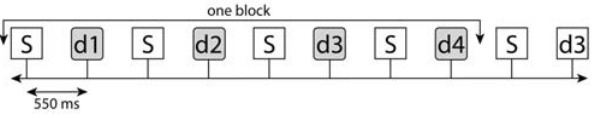
Figure 4. Summary of stimulus presentation for one block of standard and deviant stimuli. Each set of stimuli comprises one standard e.g., ‘ba-bi-bu-be’ and its corresponding four deviants e.g., d1=‘ d a-bi-bu-be’, d2=‘ba- d i-bu-be’, d3=‘ba-bi- d u-be’, d4=‘ba-bi-bu- d e’. A total of 8 stimuli are presented per block i.e., four standards alternating with four equiprobable randomly ordered deviant